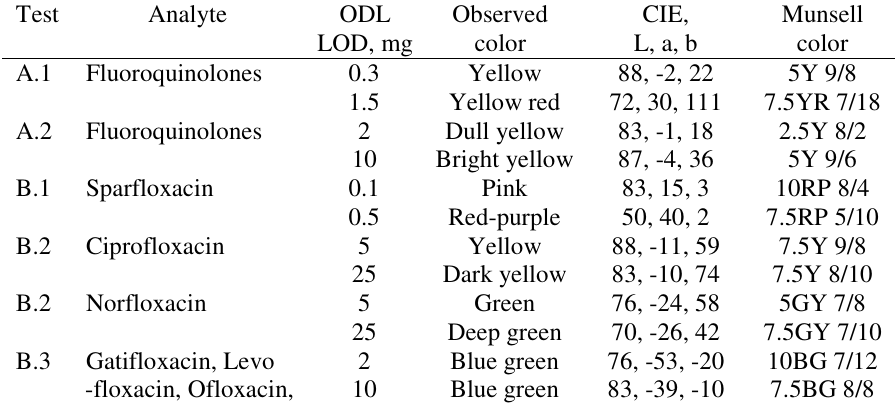
Table 3. Drug detection limit and colors produced in test A.1 to B.3 for compounds of fluoroquinolone antibiotic